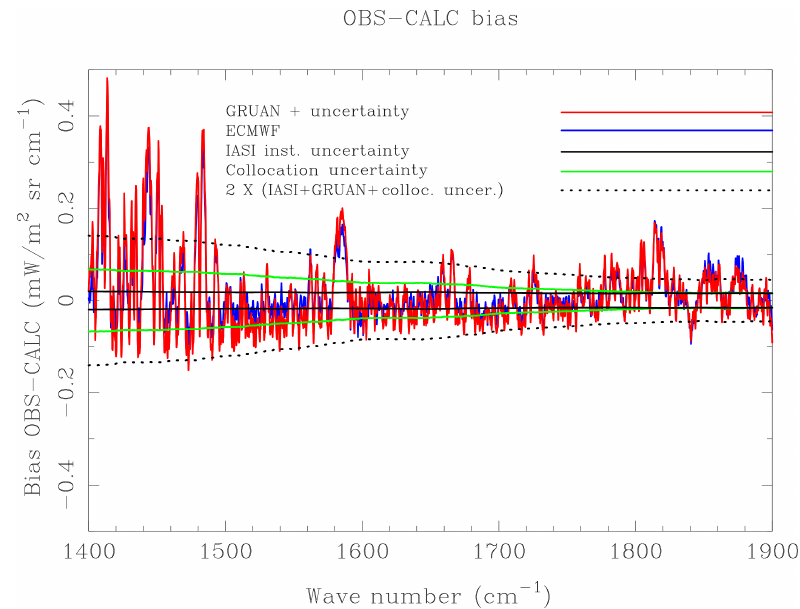
Figure 6. Average radiance difference (bias) between IASI observed and calculated radiances for the completely clear sky scenes and night- time cases. Calculated radiances are derived from GRUAN sondes (red) and ECMWF profiles (blue). The thickness of the red line (hardly noticeable) denotes the GRUAN uncertainty propagated into bias radiance space assuming no uncertainty correlation between levels. The solid black line shows the IASI instrument uncertainty for this bias. The light green line indicates the collocation uncertainty of this average or bias. The dotted black line indicates 2 times the square root of the squares of the IASI overall instrument plus GRUAN uncertainties plus q + u 2 + σ 2 term in Eq. (1) with k = u 2 collocation uncertainties for the bias (the k 1 2